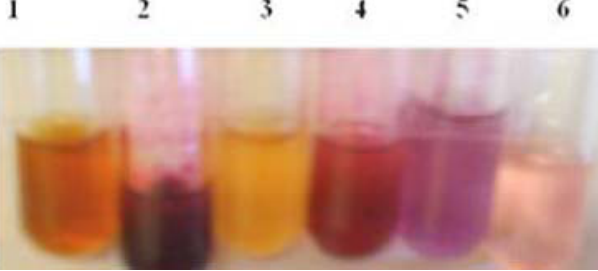
Figure 2 . S. marcescens growth and prodigiosin production in different media after 48 h at 28 °C. 1 (CSMM), 2 (MM), 3 (CSM), 4 (CWMM), 5 (CWM), 6